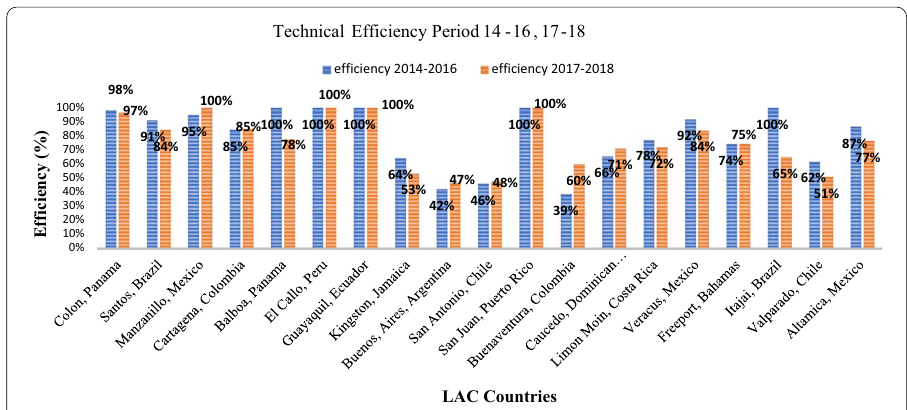
Table 8 Mean technical efficiency per region, pre and post expansion era. Source : Own elaboration Region Mean technical efficiency (TE) Pre (%) Post (%) (2010–2018) (%) South America 72 72 75 Central America